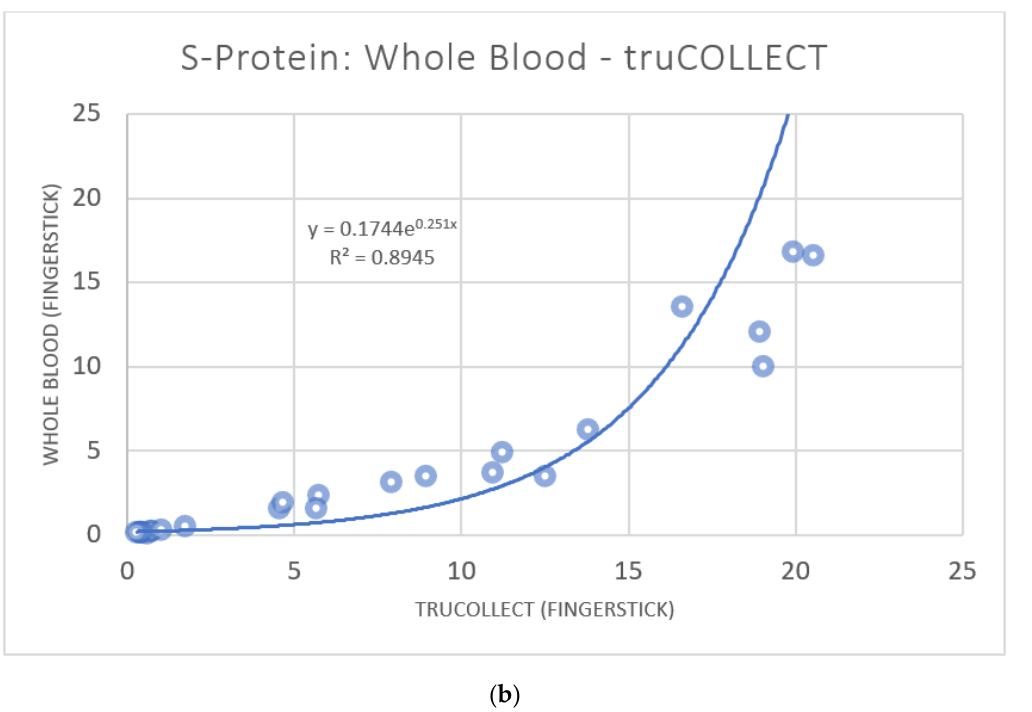
Figure 5. Correlation of SARS-CoV-2 S-protein antibodies in paired plasma and whole blood samples ( a ) and paired truCOLLECT extract and whole blood samples ( b ). A comparison of absorbance measurements from 31 donors using the SARS-CoV-2 Spike Glycoprotein ELISA kit (Abcam). Capillary fingerstick blood collected with Microtainer MAP Microtubes (Y-axis), and Venipuncture derived plasma (X-axis) are examined; r 0.898; 95% CI [0.78, 0.95] ( a ). Capillary fingerstick blood collected with Microtainer MAP Microtubes (Y-axis), and truCOLLECT extract (X-axis) are examined; r 0.934; 95% CI [0.86, 0.97] ( b ).